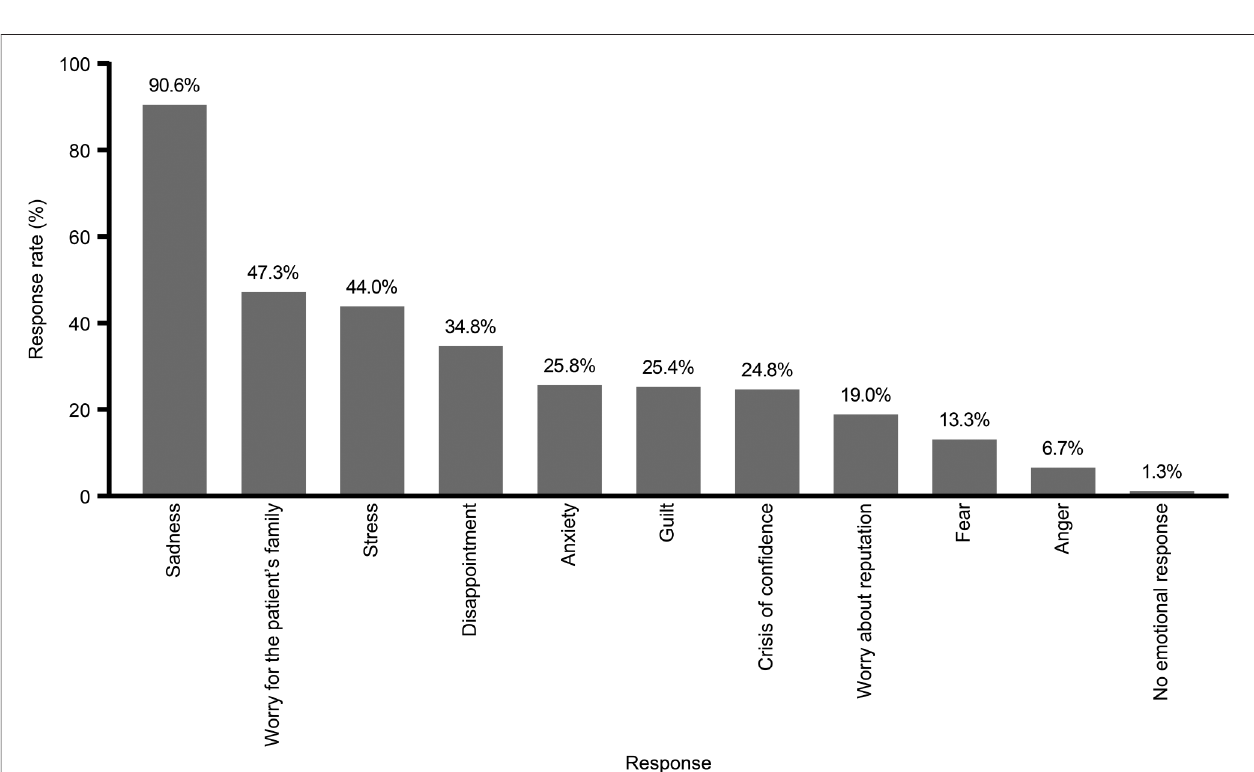
FIGURE 2 | Pro fi les of responses experienced by general surgeons to patient deaths.